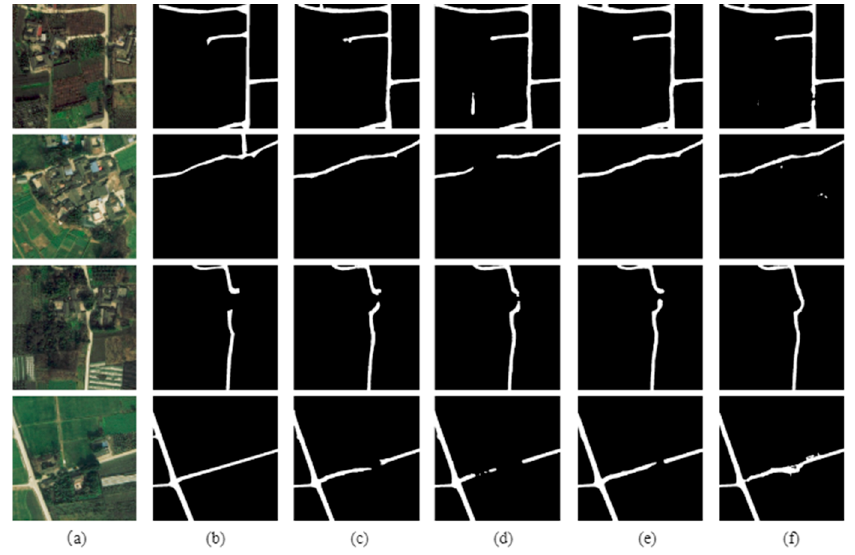
Figure 11. Results in the complex scenes: ( a ) original images; ( b ) labels; ( c ) D-LinkNet (101); ( d ) DenseNet (k = 24) + initial block; ( e ) DenseNet (k = 24) + stem block; ( f ) D-DenseNet (k = 24) + stem block.